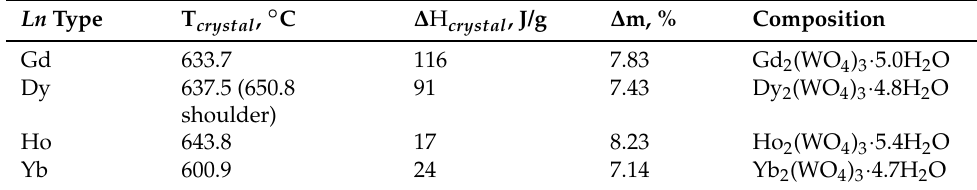
Table 2. STA results of as-prepared lanthanoid tungstates